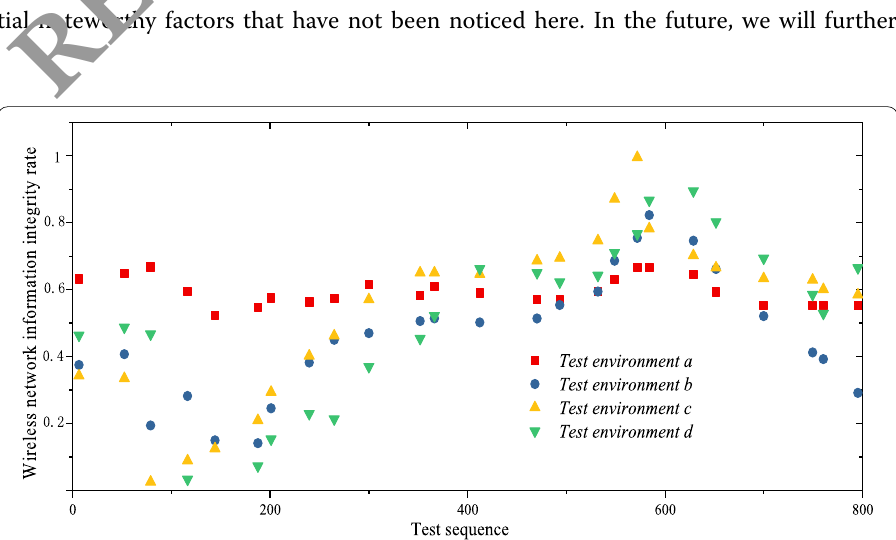
Fig. 7 The complete rate of information transmission on the wireless network during player